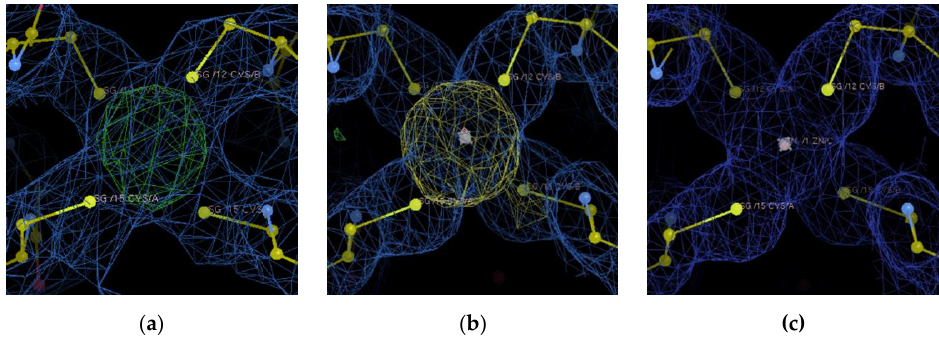
Figure 3. Metal binding site within the cage formed by the CXXC motifs of the two Atox1 protein chains in the asymmetric unit. ( a ) The 2Fo-Fc electron density map (blue, 1.5 σ ) and the Fo-Fc difference map (green +3 σ and red − 3 σ ) around the cage are shown. ( b ) Metal binding site with the anomalous map (yellow 3.5 σ ) obtained at 9690 eV, 50 eV above the Zn K-edge. ( c ) Metal binding site with the anomalous map (yellow 3.5 σ ) obtained at 9090 eV, between the Cu K-edge and the Zn K-edge. Comparison of the present structure with those of other Atox1 dimers containing different metal ions (PDB ID: 1FEE [33], 1FE0 [33], 1FE4 [33], and 4QOT [34]) indicates that the protein backbones are similar, with RMSDs of C α atoms (calculated by superposition of the homodimer present in the asymmetric unit) as low as 0.178, 0.233, 0.350, and 0.157 Å, respectively. The superposition of the PDB structures containing an Atox1 dimer is reported in Figure 4 and confirms that there are no significant backbone displacements.